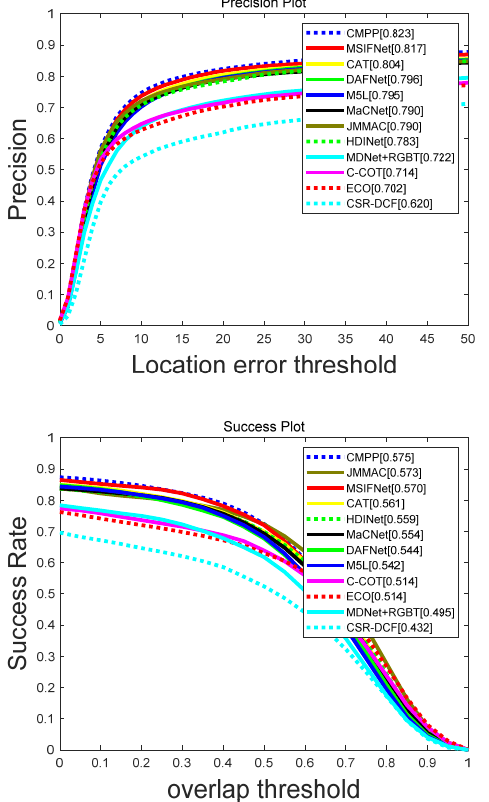
Figure 8. Evaluation curves for PR/SR metrics on RGBT234.